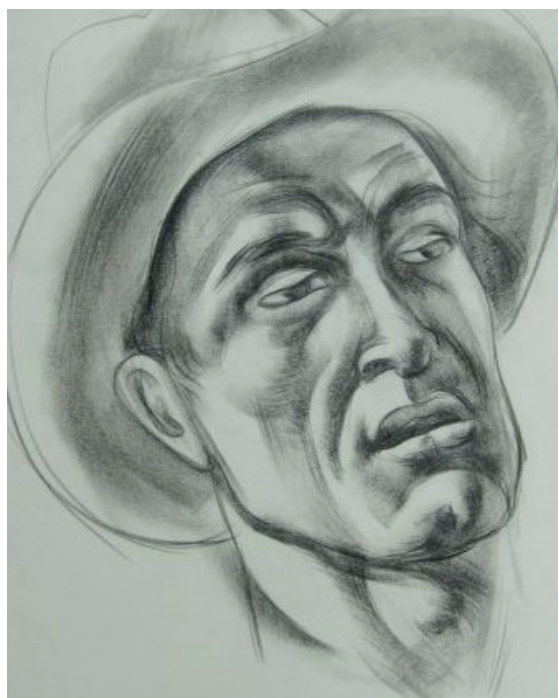
Figure 8. This study for the San Antonio frescoes exemplifies several hallmarks of Cook’s